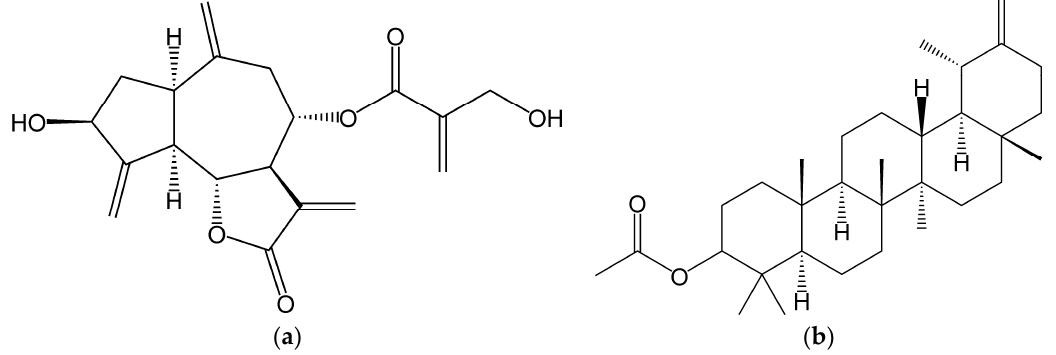
Figure 1. Structures of major lipophilic compounds identified in C. cardunculus L. var. altilis (DC) leaves and florets: ( a ) Cynaropicrin; ( b ) Taraxasteryl acetate.